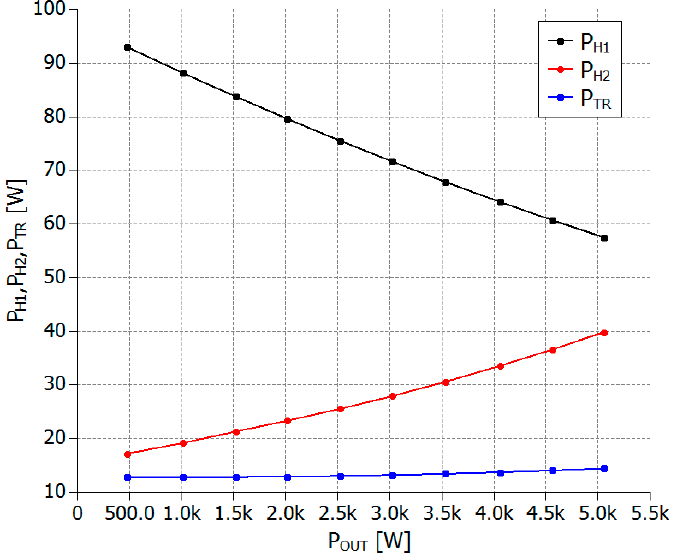
Figure 15. The estimated power loss distribution of the tested DAB converter.